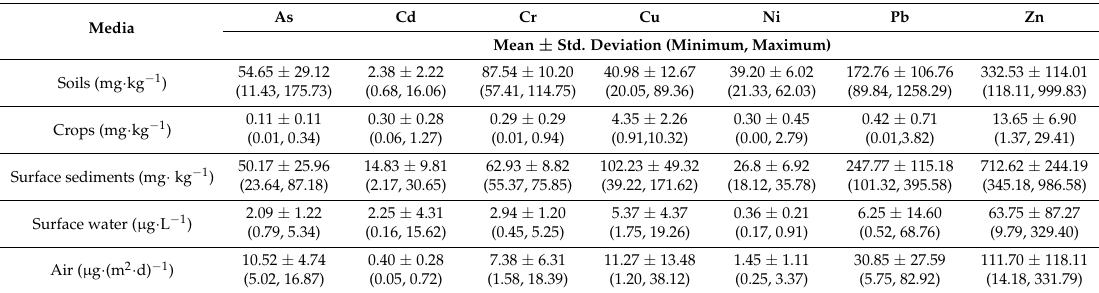
Table 1. Trace metal concentrations in different media in the study area.